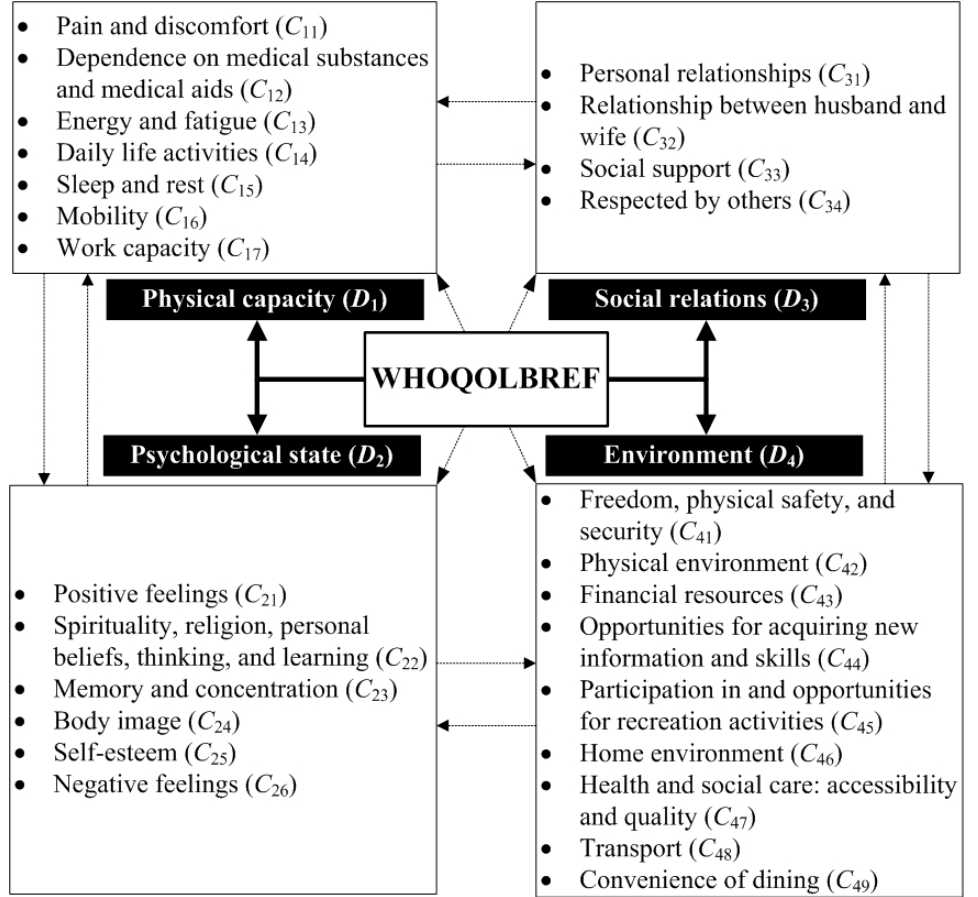
Figure 1. Indicator structure used in this study based on the Chinese version of WHOQOL-BREF (Brief version of quality of life framework proposed by the World Health Organization).